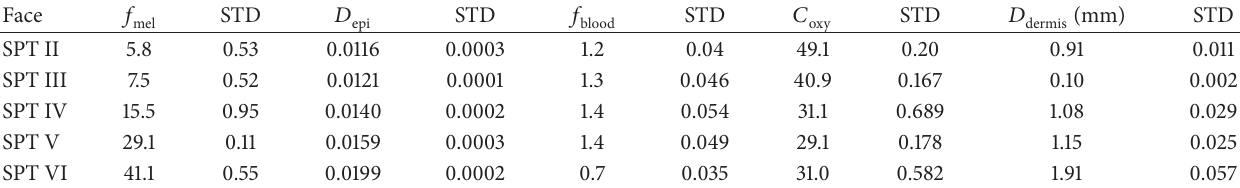
Table 4: Face parameters estimation for SPT II, III, IV, V, and VI.